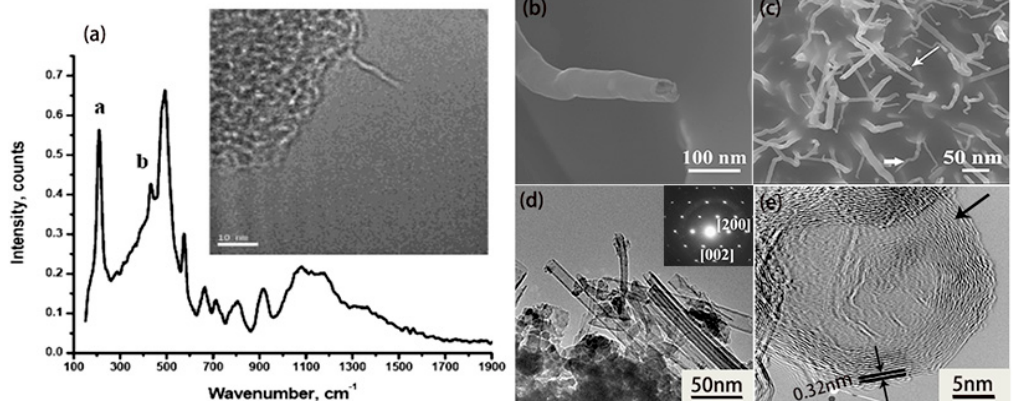
Figure 4. ( a ) Raman spectrum and TEM image (inset) of a single-wall boron nanotube [52]. Copyright 2004, American Chemical Society. ( b , c ) Low-resolution and high-resolution SEM images of the boron nanotubes (BNTs) (white arrows) at the initial growth stage. ( d ) TEM image of the BNTs. The inset is the corresponding SAED pattern. ( e ) The HRTEM image of the top of the BNT [53]. Copyright 2010, Royal Society of Chemistry.